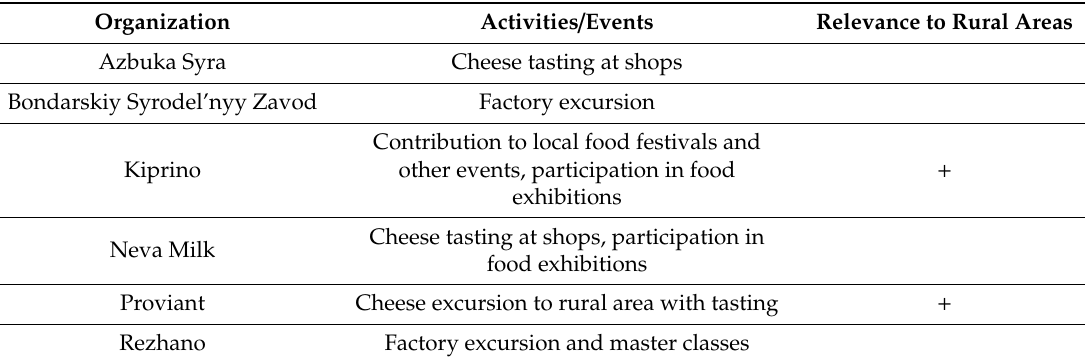
Table 3. Public activities of the analyzed organizations (based on information on their official web-pages).